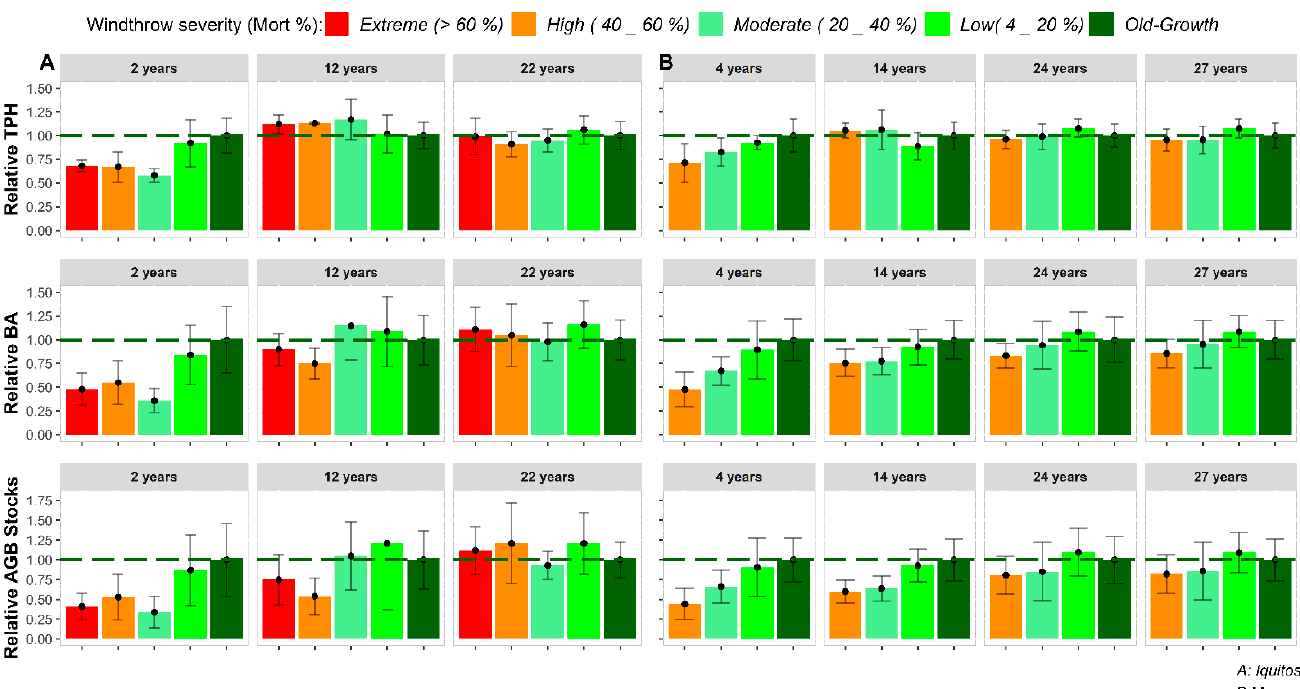
Figure 3. Recovery of structural attributes in Northwestern and Central Amazon windthrown forest. Structural attributes: trees per hectare (TPH), basal area (BA) and aboveground biomass (AGB). Sites: ( A ) Iquitos (NWA) and ( B ) Manaus (CA). Dashed dark green lines show the old-growth mean and vertical bars the 95% confidence intervals (error bars).